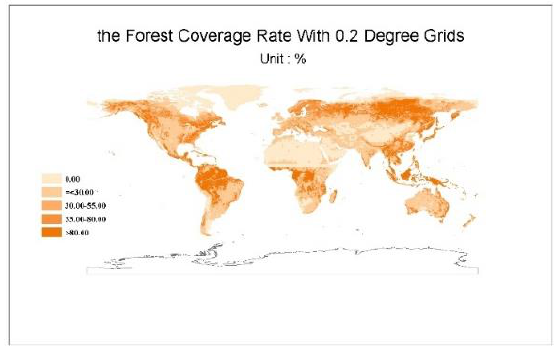
Figure1: The forest coverage rate with 0.2 degree grids in 2010.